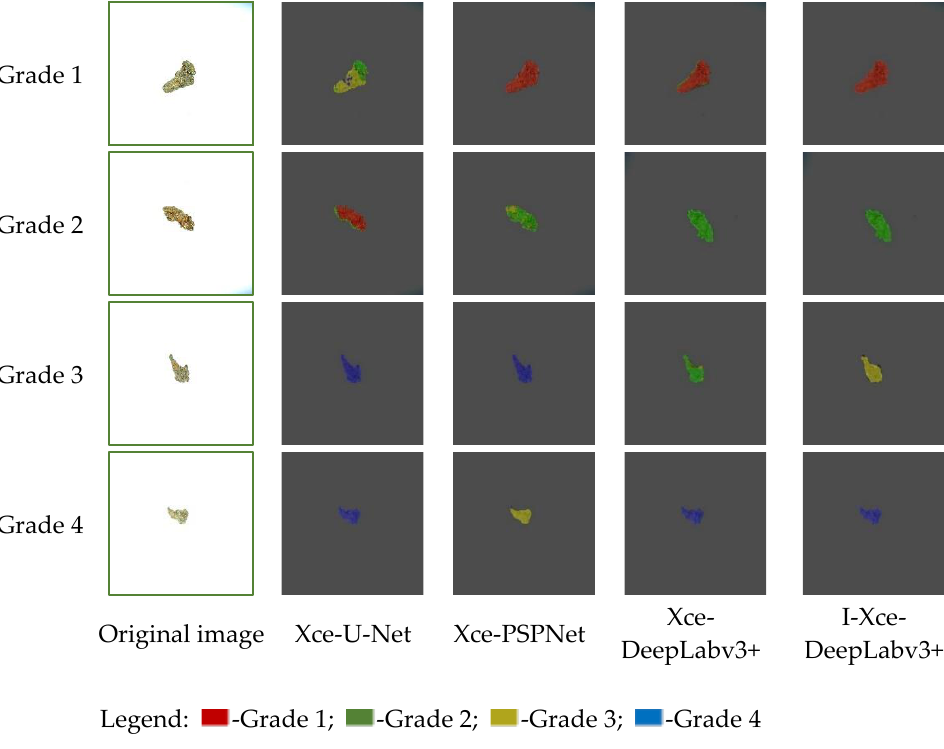
Figure 7. Visualization of segmentation effects of different